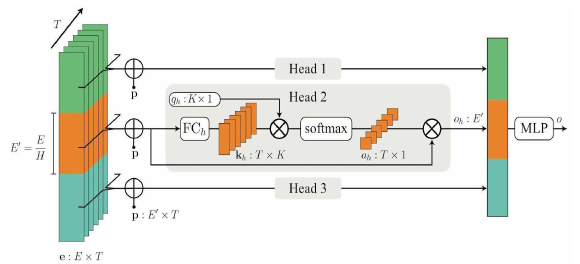
Figure 3 . Architecture of the PSE + LTAE approach